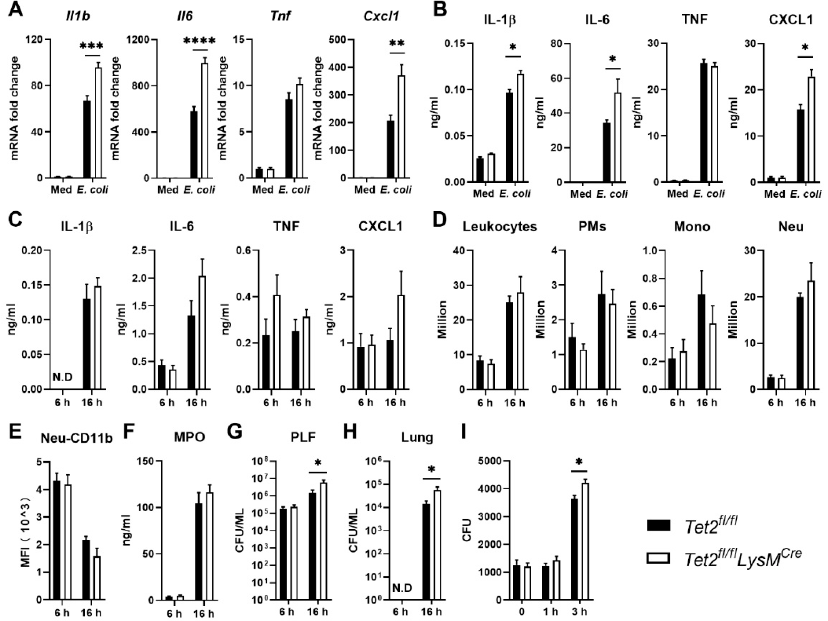
Figure 6. Myeloid Tet2 deficiency impairs antibacterial defense during E. coli induced peritonitis.